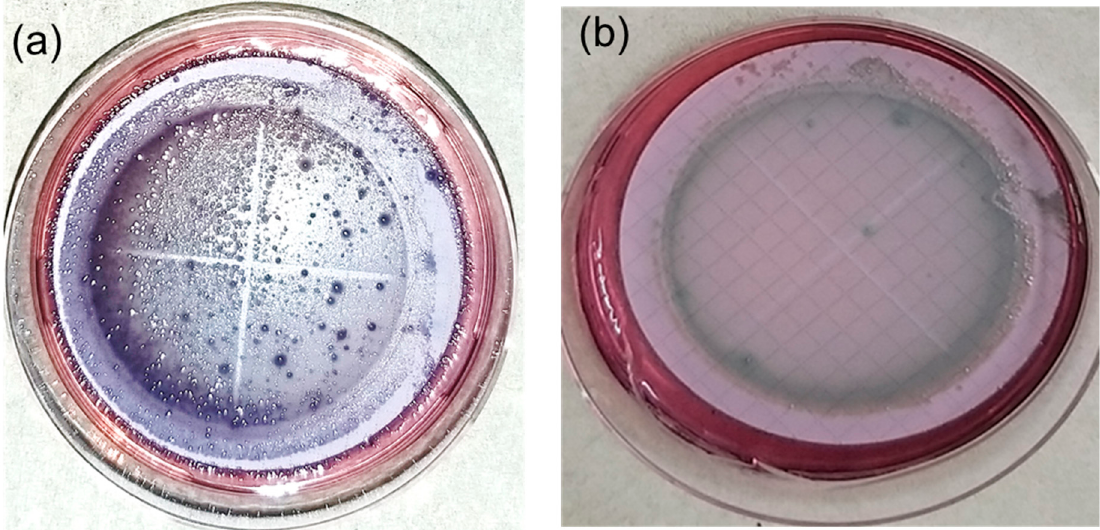
Figure 13. Pictures of petri plates for detection of faecal coliforms following 24 h incubation at 44.5 °C ( a ) before water treatment and ( b ) after water treatment with CXTi. Only blue colonies are counted, which are considered to be faecal coliform colonies. E. coli form dark blue flat colonies. Table 4. Antimicrobial results after performing tests against reduction in total and faecal coliform and E. coli in control conditions and treatment using CXTi synthesised in this study.